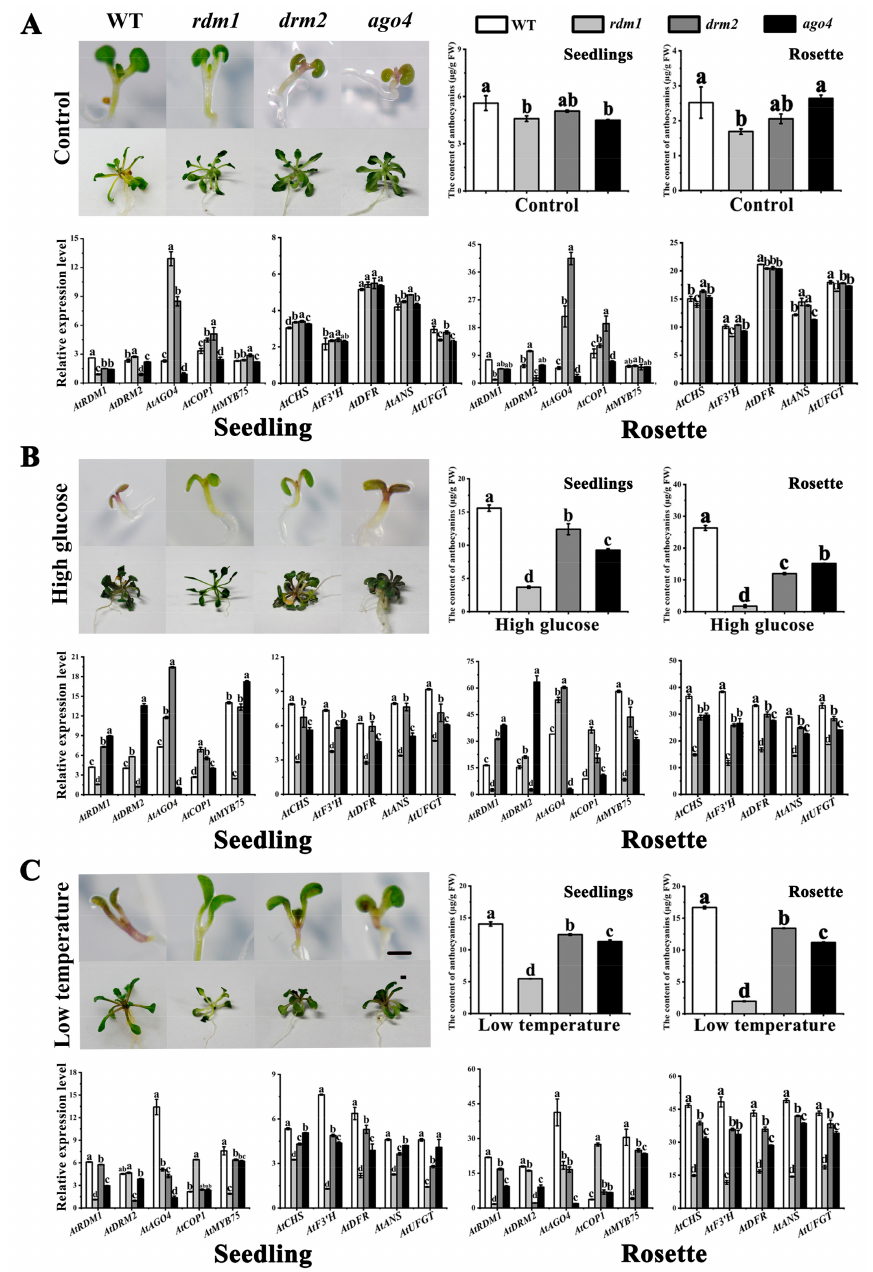
Figure 7. AtRDM1 affects anthocyanin biosynthesis in Arabidopsis thaliana seedlings and rosette leaves in response to stress. ( A ). Phenotype, anthocyanin content and relative gene expression in A. thaliana seedlings and rosette leaves in the control group. ( B ). Phenotype, anthocyanin content and relative gene expression in A. thaliana seedlings and rosette leaves treated with high glucose. ( C ). Phenotype, anthocyanin content and relative gene expression in A. thaliana seedlings and rosette leaves treated with low temperature. Bar = 1 mm. Real Time (RT)-quantitative (q) PCR (RT-qPCR) and HPLC were performed with three biological replicates. Error bars indicate the standard error of the mean ± SE of three replicate measurements. Different letters above the bars indicate significantly different values ( p < 0.05), calculated using one-way analysis of variance (ANOVA) followed by a Duncan’s multiple range